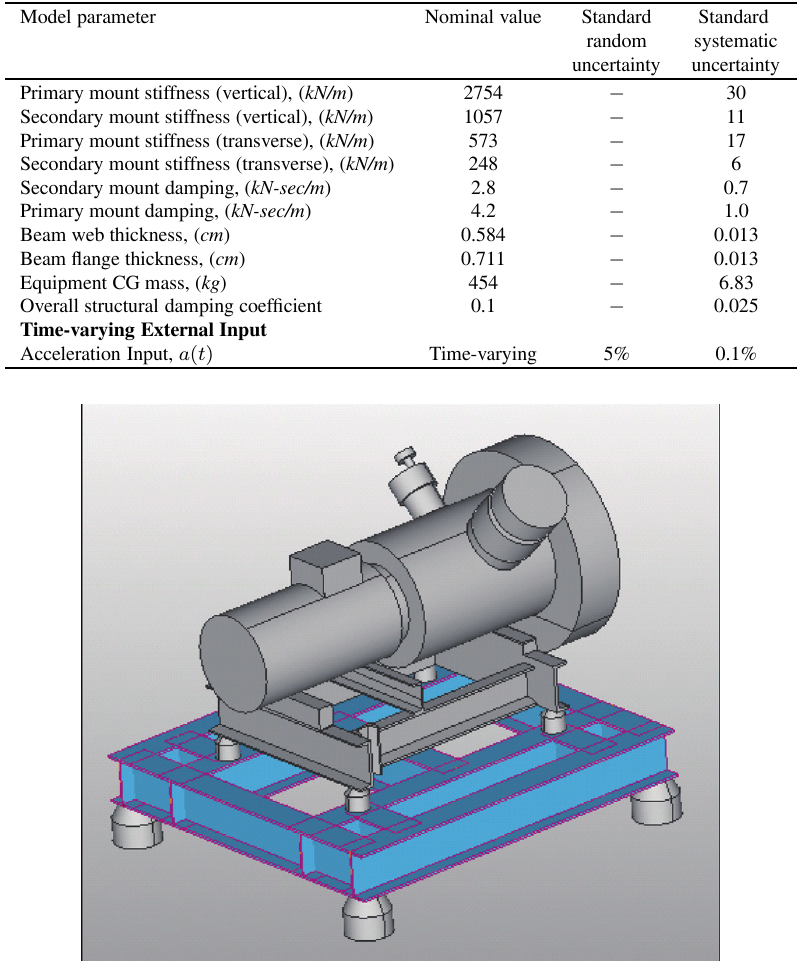
Table 2 FEA case study model arguments and standard uncertainties